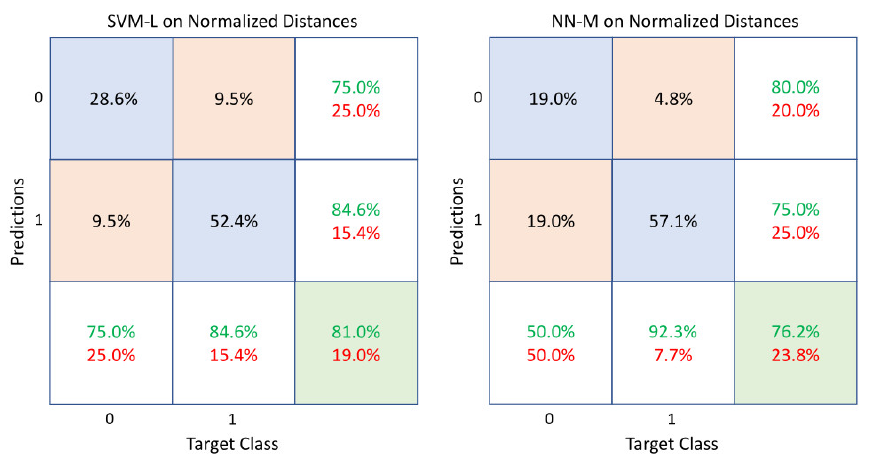
Figure 6. Confusion matrices of SVM-L and NN-M when normalized distances were used as feature vectors. The diagonal cells show the correctly classified observations (accuracies), whereas the off- diagonal cells show the incorrectly classified ones. The far-right column of each matrix shows the precision or positive predictive value (green) and the false discovery rate (red). The bottom row shows the sensitivity or true positive rate (green) and the false negative rate (red). Class 0 and class 1 represent healthy subjects and sick patients,